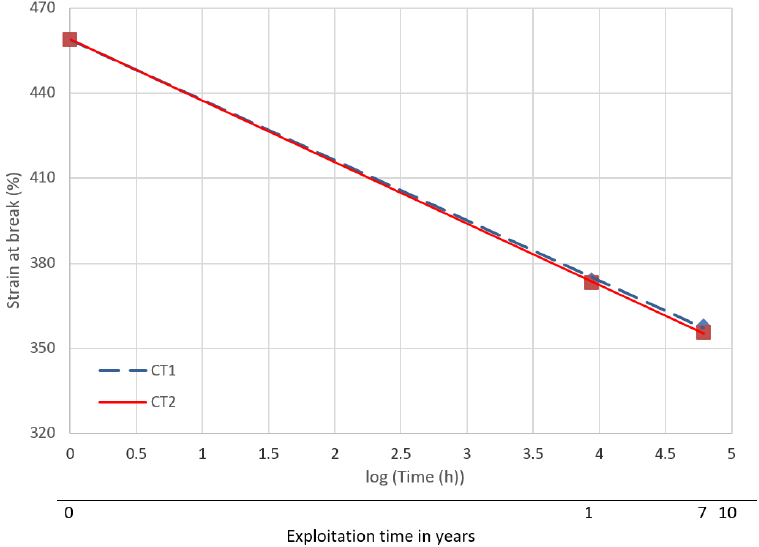
Figure 18. Strain at break dependence on operation time for cooling tower 1 and 2.